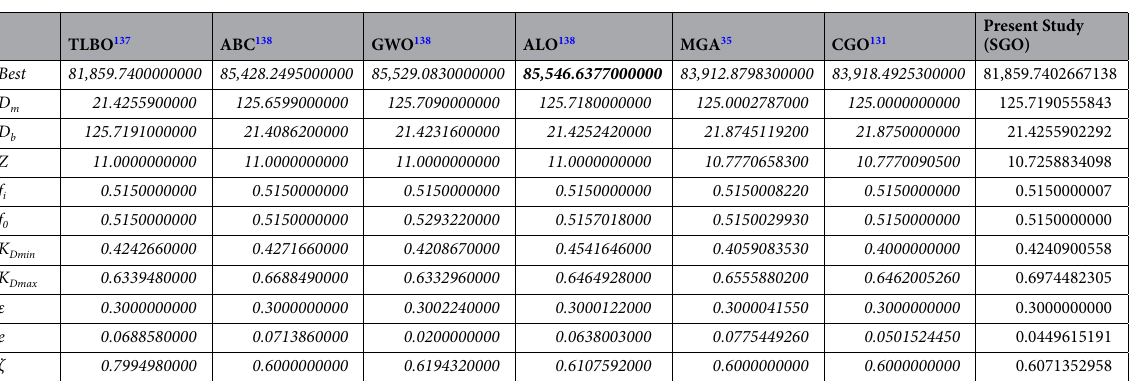
Table 14. Comparison of the best solutions for the rolling element bearing design problem. Pitch diameter (Dm), ball diameter (Db), total number of balls (Z), inner raceway curvature coefficient (fi), and the outer raceway curvature coefficient (f0). Significant values are in bold and italics.